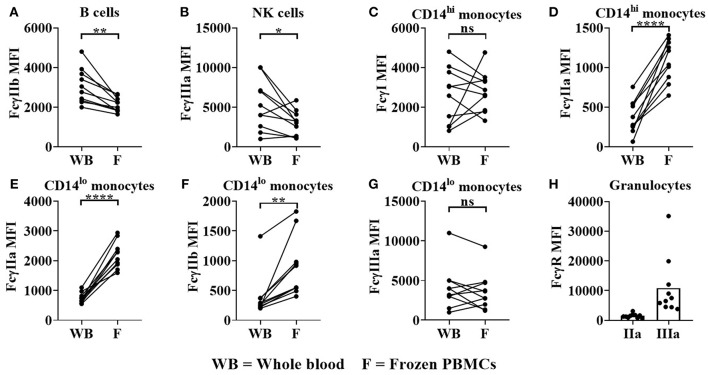
FcγR expression in donor matched whole blood (WB) and frozen (F) PBMCs. Using flow cytometry, FcγR expression was quantified on (A) B cells (B) NK cells, (C,D) classical monocytes, (E–G) non-classical monocytes and (H) granulocytes in donor matched WB and frozen PBMC samples. FcγRIIa (IIa) and FcγRIIIa (IIIa) expression on granulocytes was quantified in WB only. Each point represents a donor, bars represent group means, (n = 10). *p < 0.05, **p < 0.01, ****p < 0.0001 and ns = non-significant.